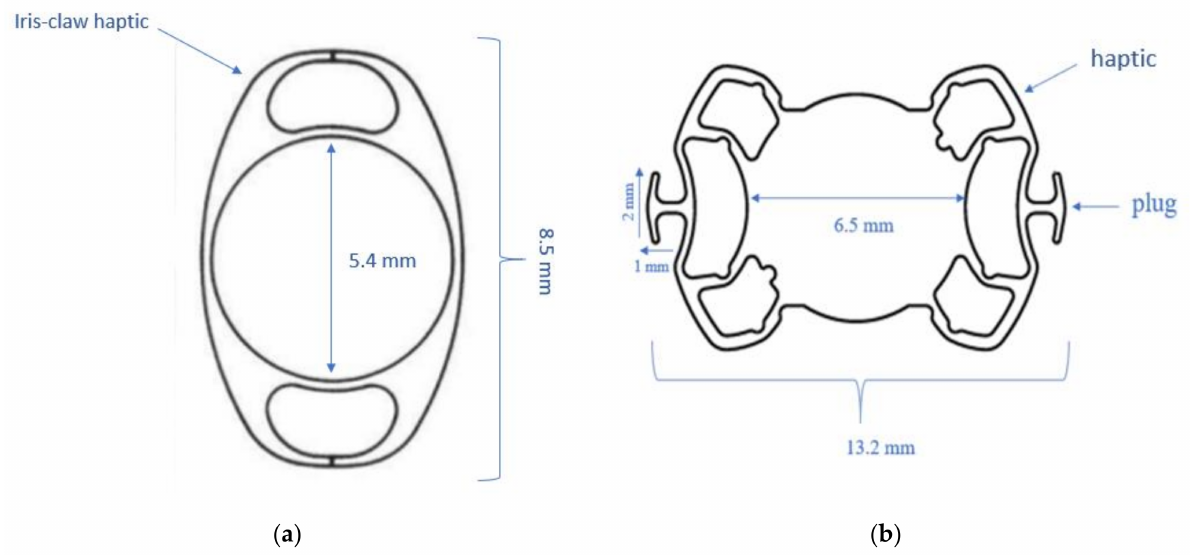
Figure 1. ( a ) Schematic drawing of an iris claw lens (Artisan, Ophtec). ( b ) Schematic drawing of a sutureless trans-scleral plugs fixated lens (Carlevale lens,